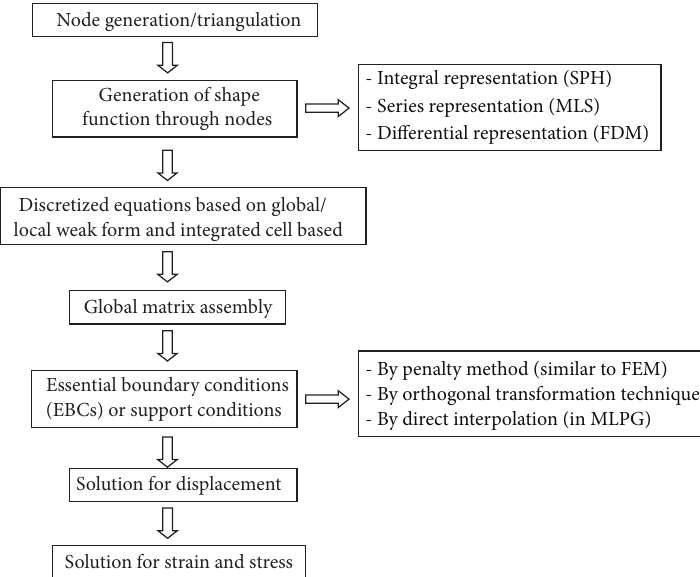
Figure 1: Procedural steps in meshfree